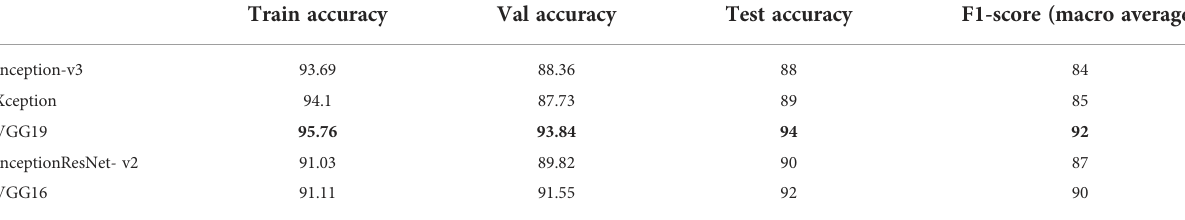
TABLE 4 AgriNet models